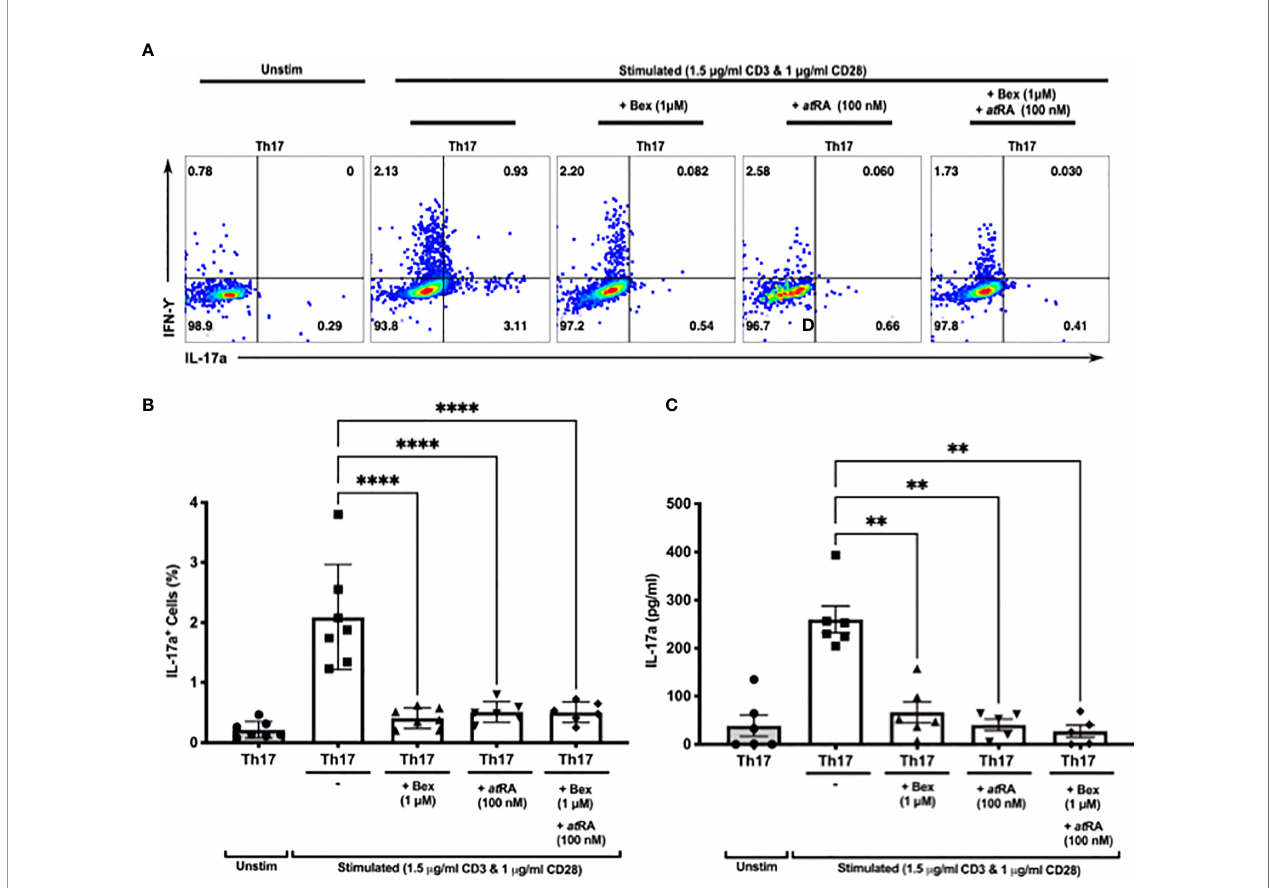
FIGURE 3 | Bexarotene signi fi cantly reduces the differentiation of CD4+ naive lymphocytes into Th17 IL-17a+ cells in vitro . (A) Representative dot plots showing intracellular Th17 and IFN- g following culture of human naiïve CD4 cells in Th17 skewing conditions +/- bexarotene, +/-atRA or both. (B) Summary data showing percent IL-17+ cells as a percent of total live CD4 cells at the end of culture (n = 7). (C) Supernatant IL-17a as measured at day 7 (n = 7). Shown are mean values ± SEM. Signi fi cance was calculated with repeated measures one-way ANOVA. S ̌ idaa ́ k ’ s correction was performed. **p < 0.01, ****p < 0.0001.